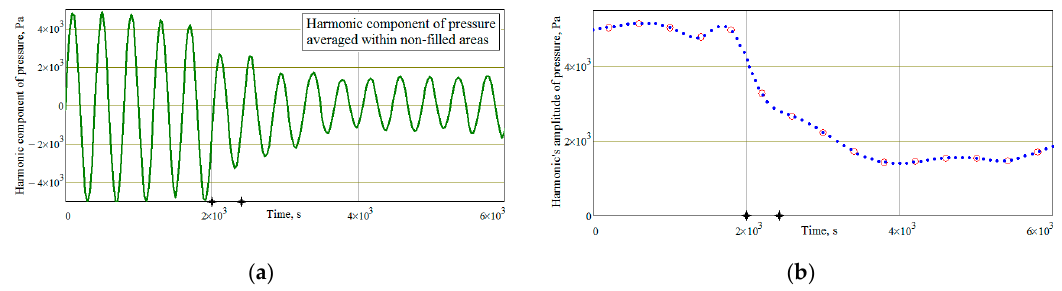
Figure 16. Change of the relative resin filled and unfilled volume ( a ) and the averaged pressure inside the unfilled regions ( b ) during vacuum infusion.